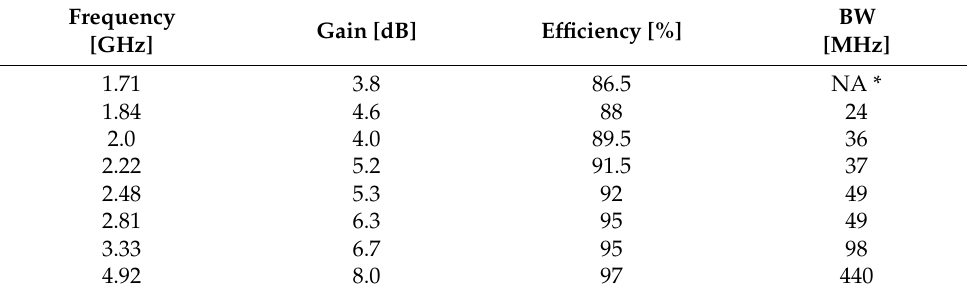
Table 2. Gain and radiation efficiency.